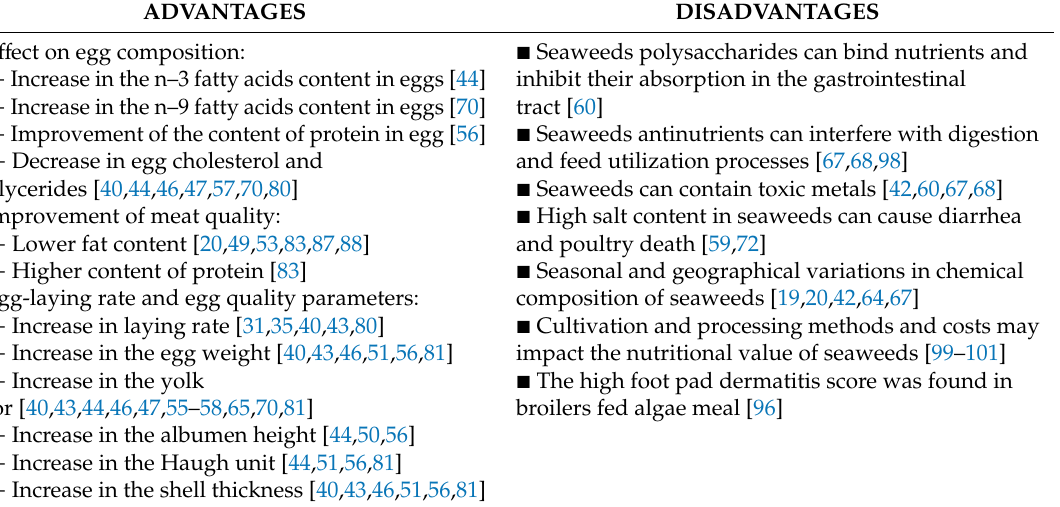
Table 3. Examples of advantages and disadvantages of seaweeds in poultry feeding. ADVANTAGES